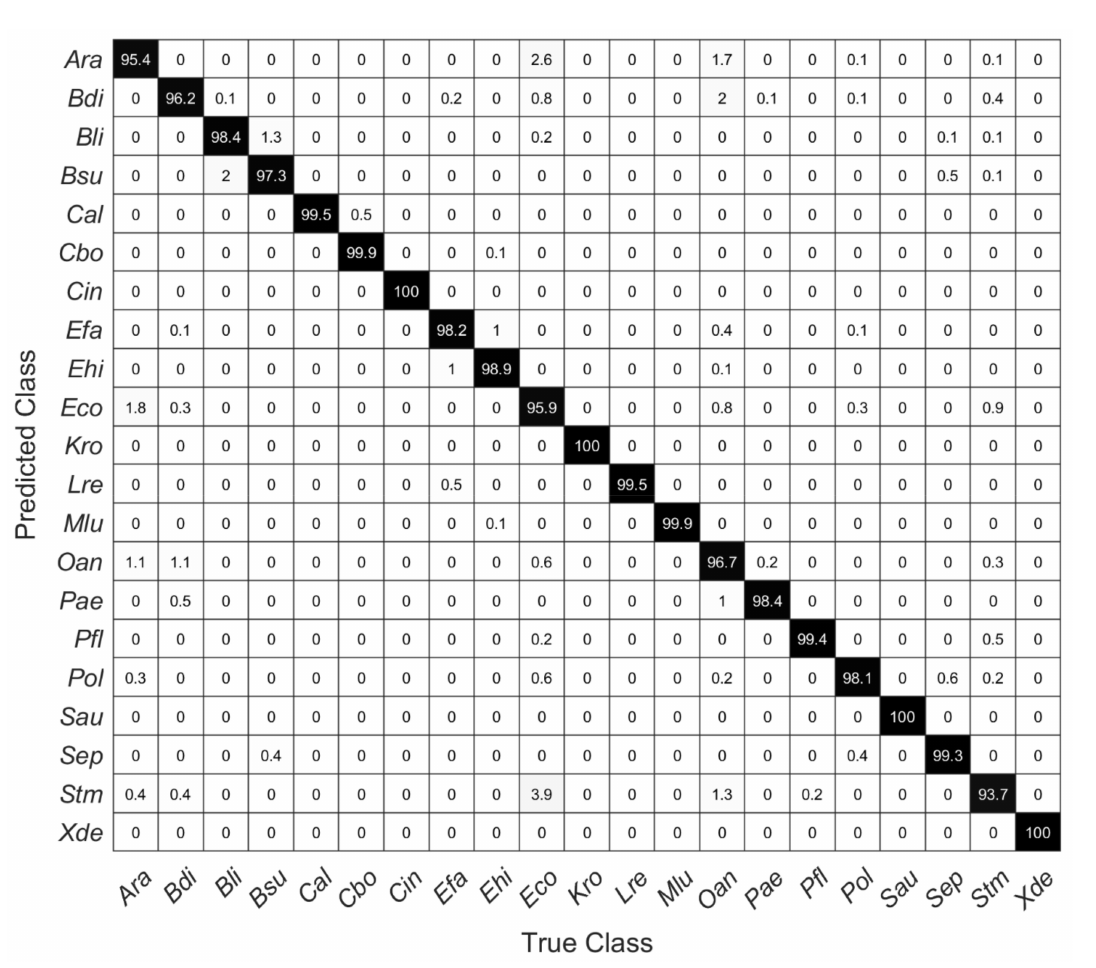
Figure 5. Confusion matrix of a five-fold cross-validated SVM model using the first 20 PCs showing the percentage of right and false-positive predictions of each